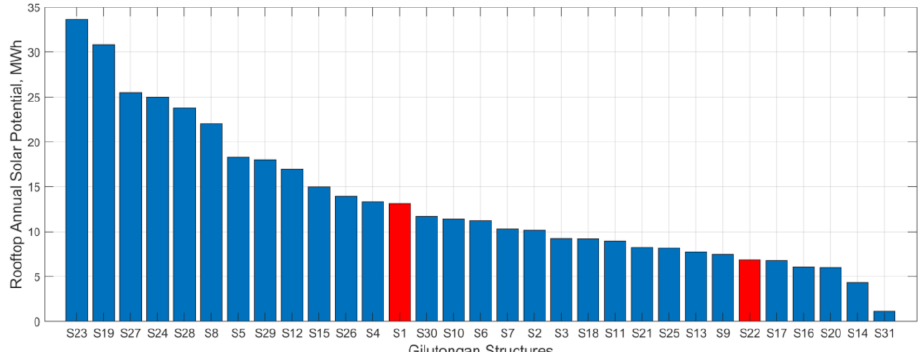
Figure 10. Rooftop solar potential of the structures on Gilutongan Island that are suitable for rooftop solar PV installation. The bars in red indicate the structures whose rooftops were used for the Gilutongan Island solar microgrid.